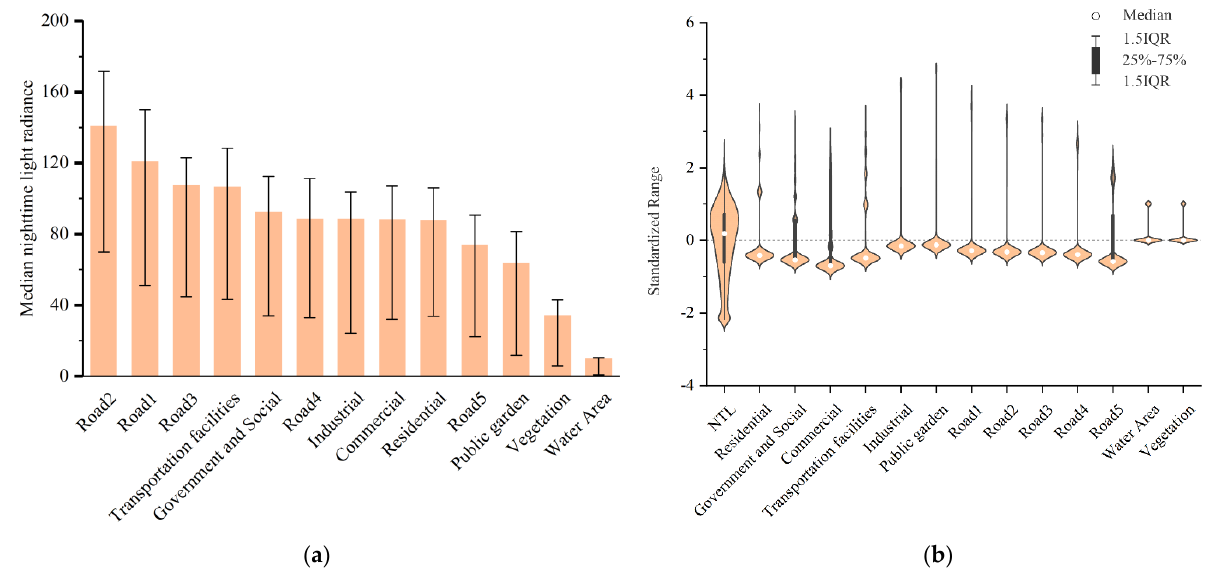
Figure 5. Exploratory statistical analysis: ( a ) NTL radiance of different urban surface in nWcm − 2 sr − 1 (here, the lower quartile, median, and upper quartile are presented); ( b ) the violin plot of different urban surface feature.